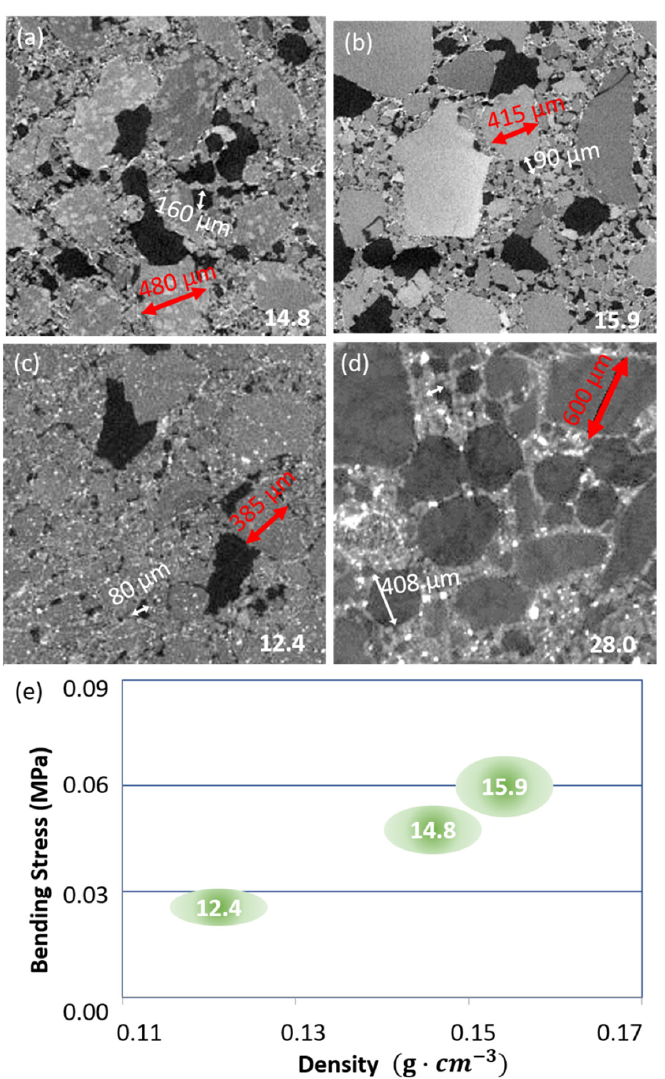
Figure 7. Tomography cross-section of aerogel composite. ( a ) SBA T composite V f binder 2% IP = 17%; ( b ) SBA X V f binder 2.0% IP = 12%; ( c ) SBA X SiC V f binder 2% IP = 6%, please not the micron size isolated SiC particles paving space in white; ( d ) hydraulic binder, no quantitative analysis; ( e ) experimental values (flexural stress versus density and thermal conductivity measured given on graph in (mW · m · K − 1 ) issued from ref. [45,48]).